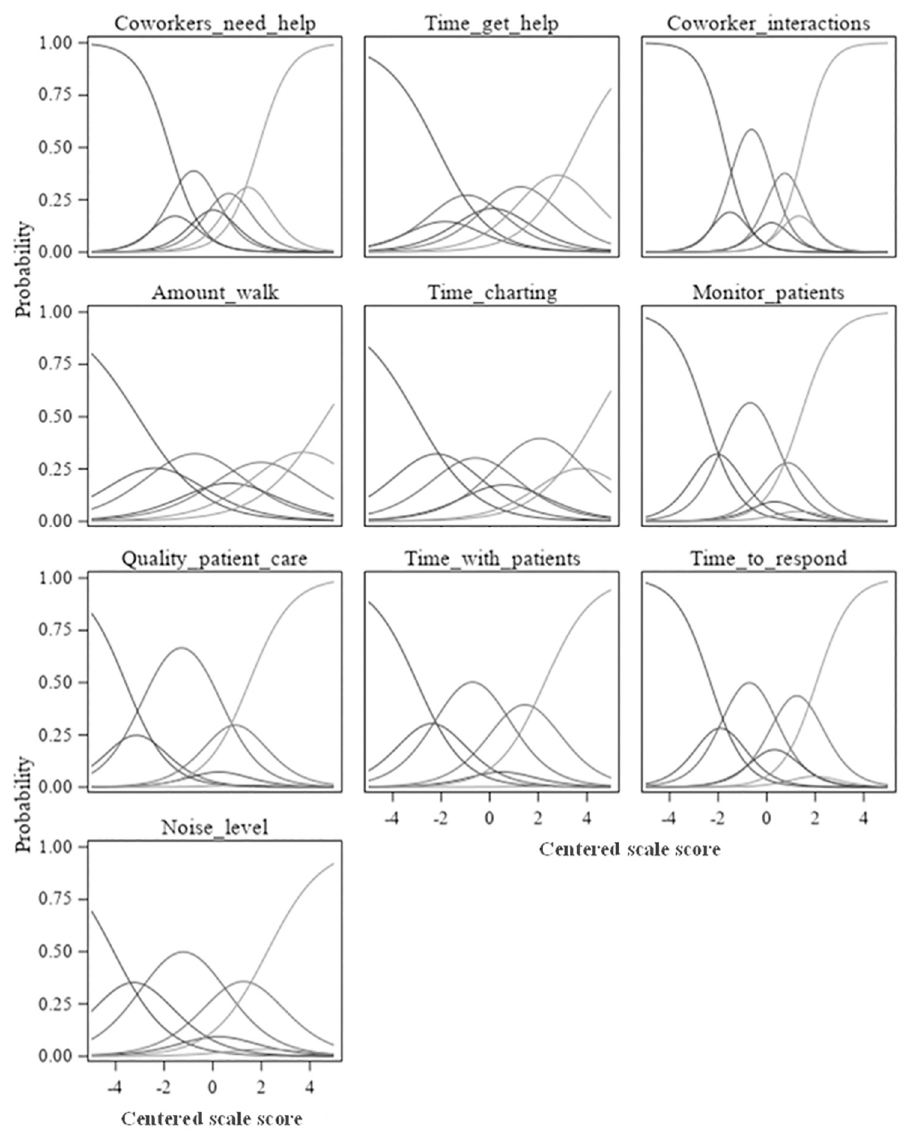
Fig 3. Phase 1 category response